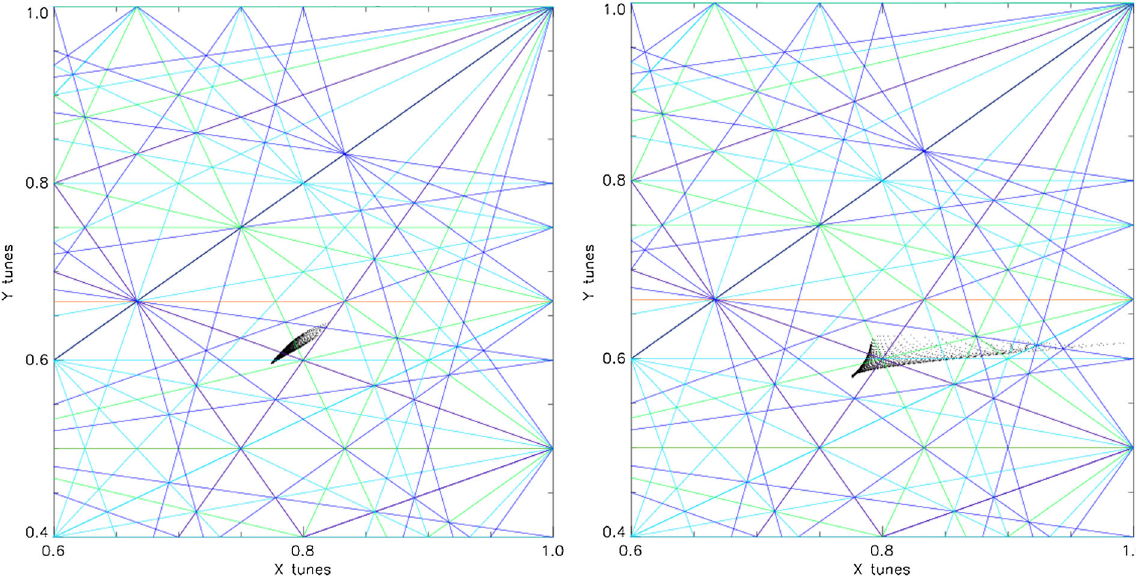
FIG. 11. (Color) The left side shows a well-behaved tune footprint, while the right side shows a more diffuse tune footprint. The differences are caused by different quadrupole settings. The lines are the resonance lines up to order six, with the same color scheme as Fig. 5.